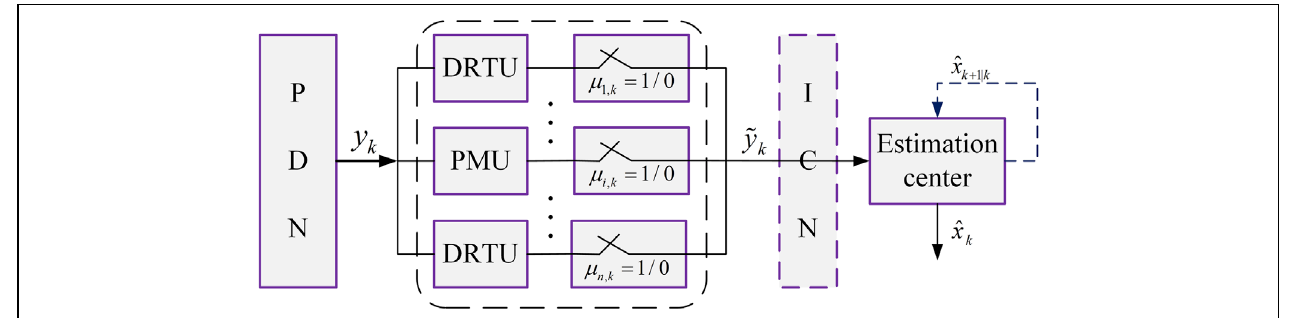
FIGURE 2 | Event-triggered